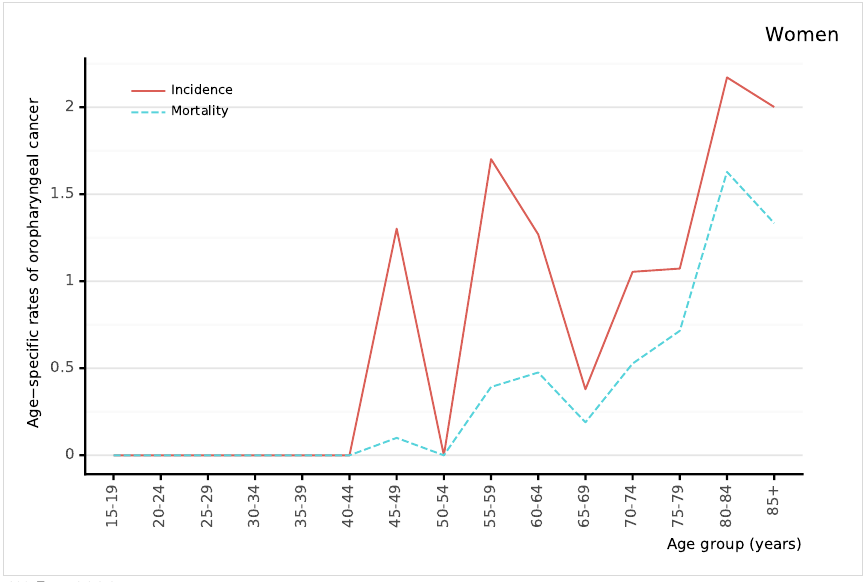
Figure 41: Comparison of age-specific oropharyngeal cancer incidence and mortality rates among women in Peru (estimates for